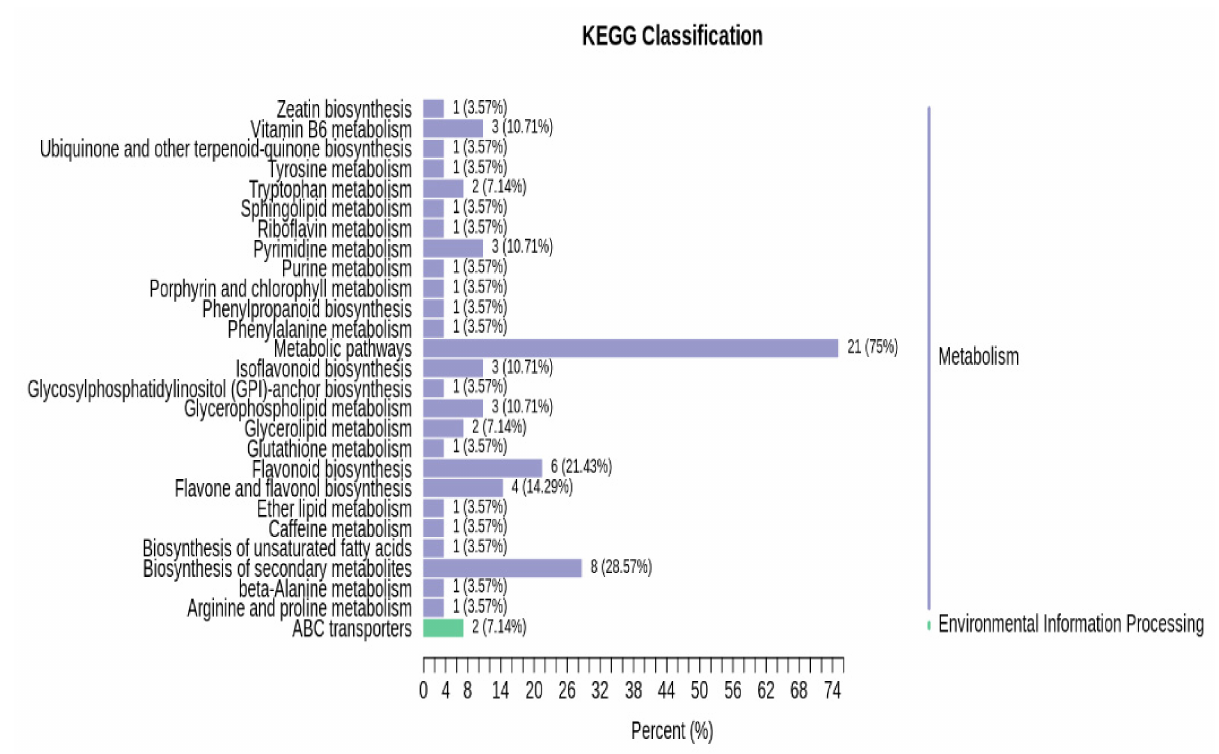
Figure 8. The KEEG enrichment of differentially available metabolites in tomato fruits.